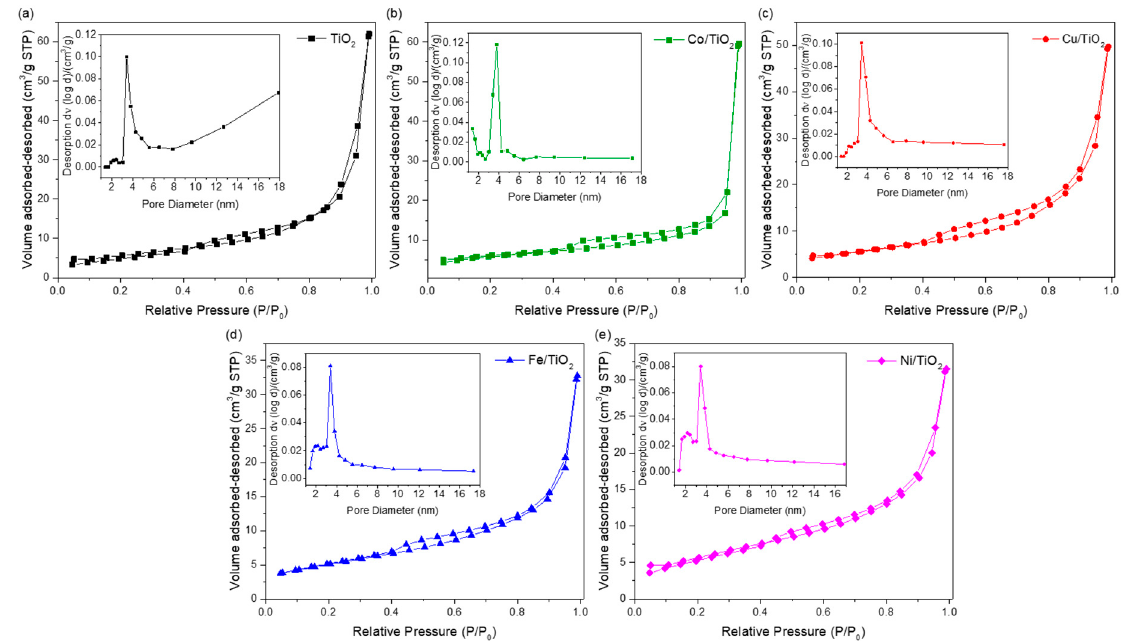
Figure 7. Nitrogen adsorption-desorption isotherms and the corresponding pore size distribution curves (inset): ( a ) TiO 2 , ( b ) Co/TiO 2 , ( c ) Cu/TiO 2 , ( d ) Fe/TiO 2 and ( e ) Ni/TiO 2 .